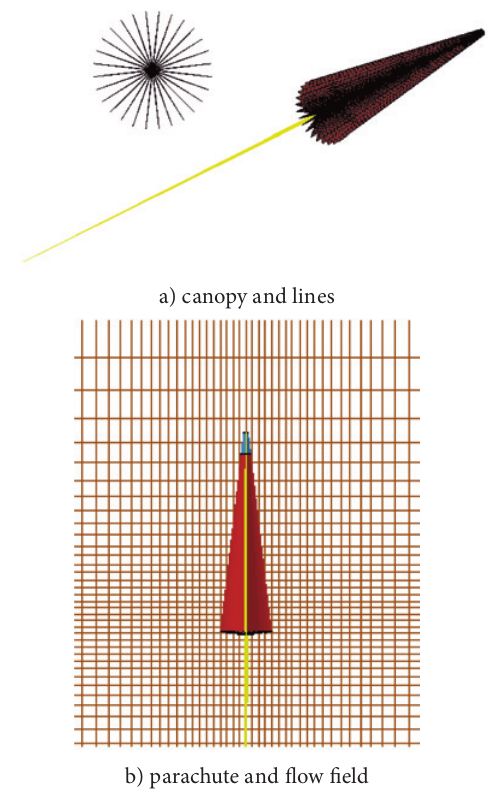
Fig. 1. Finite element model of parachute